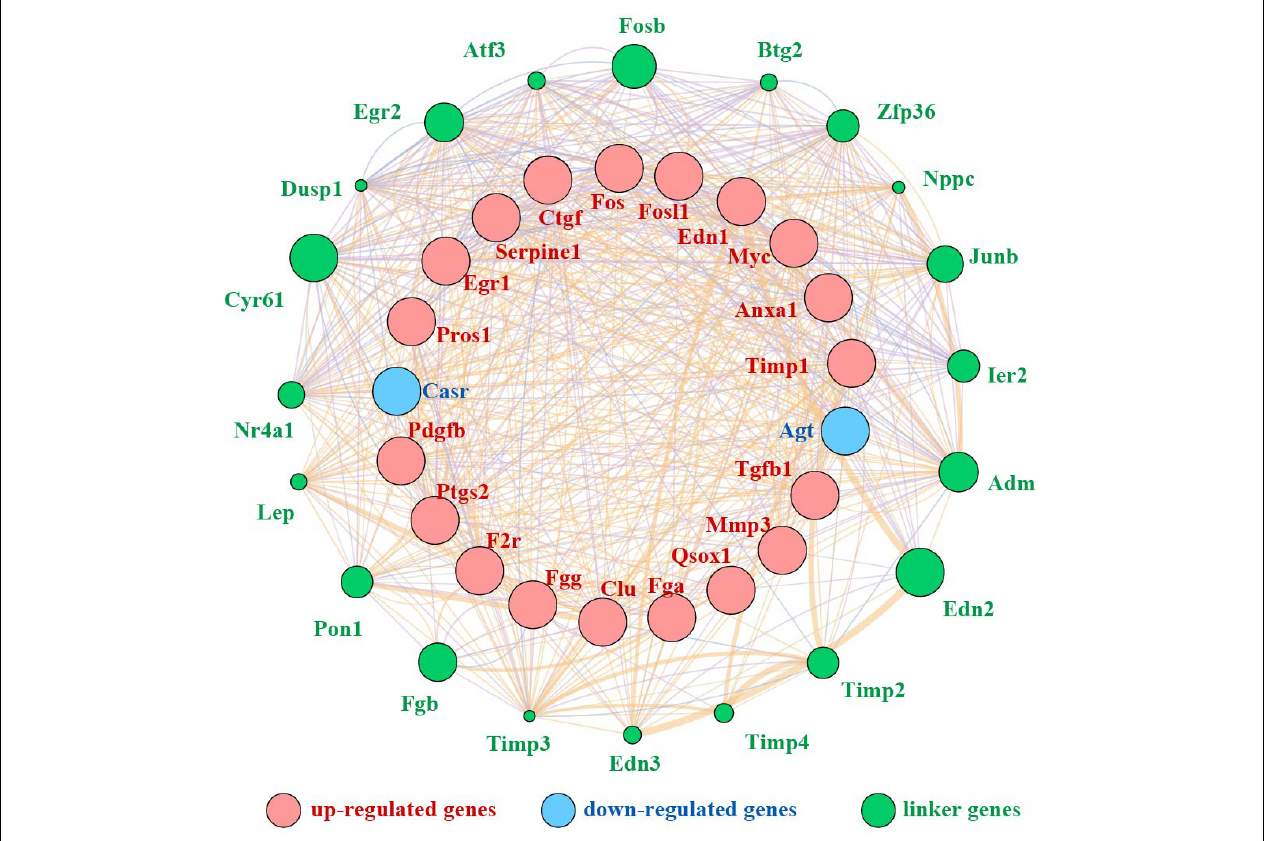
FIGURE 6 | PPI network of 21 hub genes. Red nodes represent upregulated genes, blue nodes stand for downregulated genes, and green nodes represent the linker